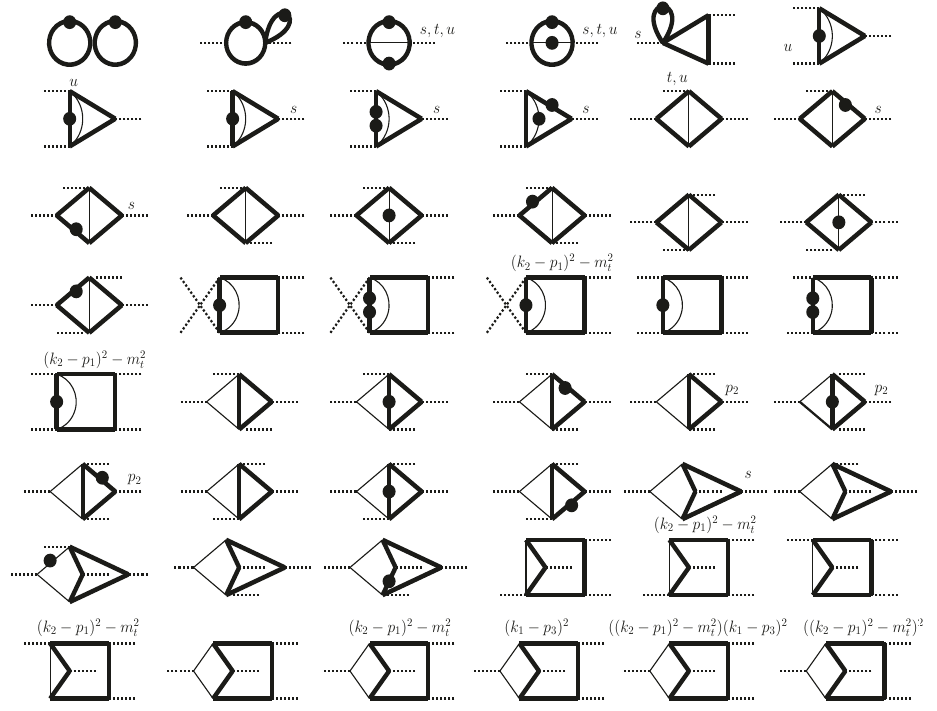
Figure 5 . Pre-canonical master integrals in topology E. The thick lines represent massive propa- gators (from top quarks) and the thin lines denote massless propagators (from gluons). The labels s , t and u on the external lines represent the (squared) momenta (cid:13)owing through those legs. The external lines without labels have light-like